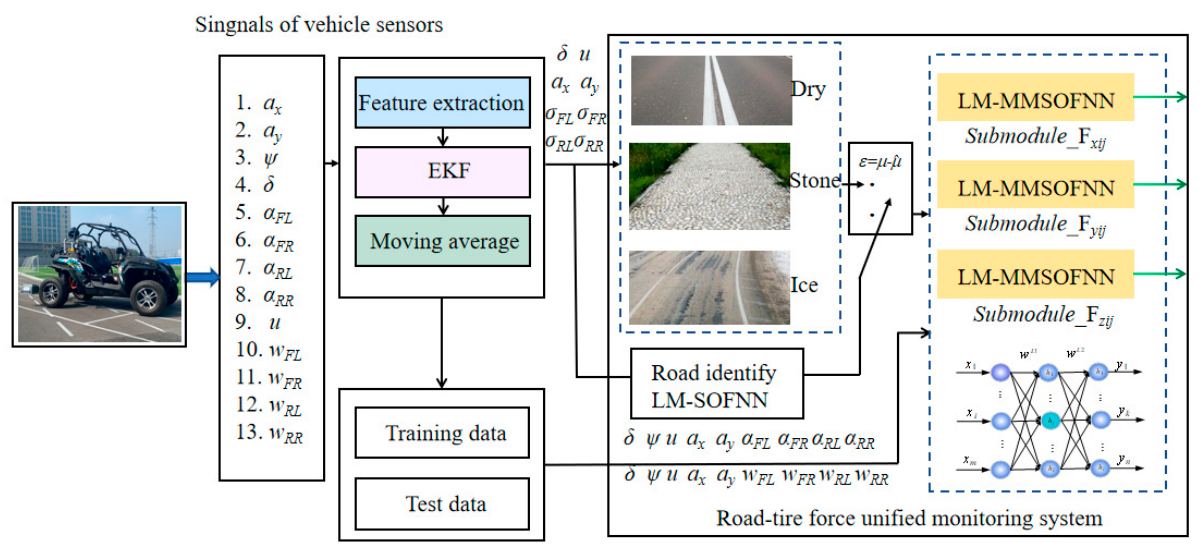
Figure 9. Structure diagram of the road recognition and tire force online estimation.